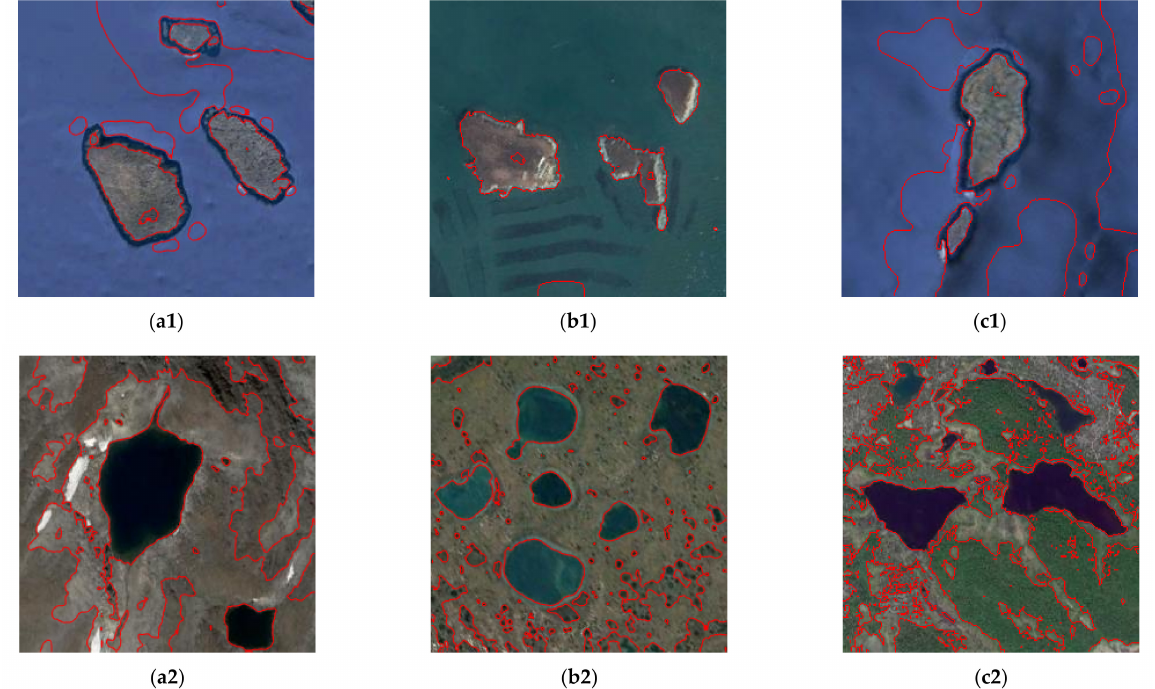
Figure 18. Experimental results based on active contour model algorithm: ( a1 ) Island image